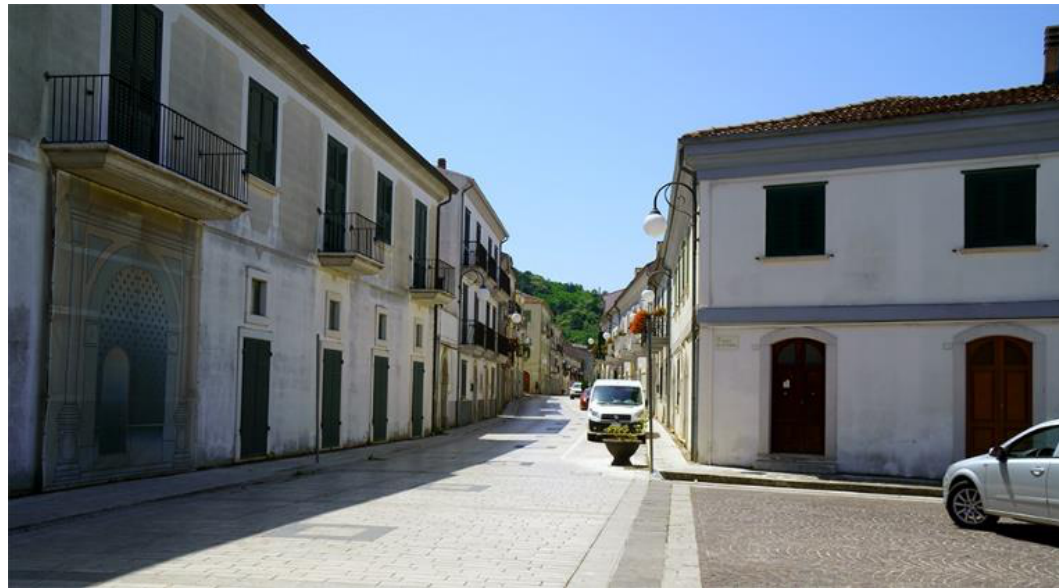
Figure 103. Teora: part of the restored historical centre (photos by [35,36]).